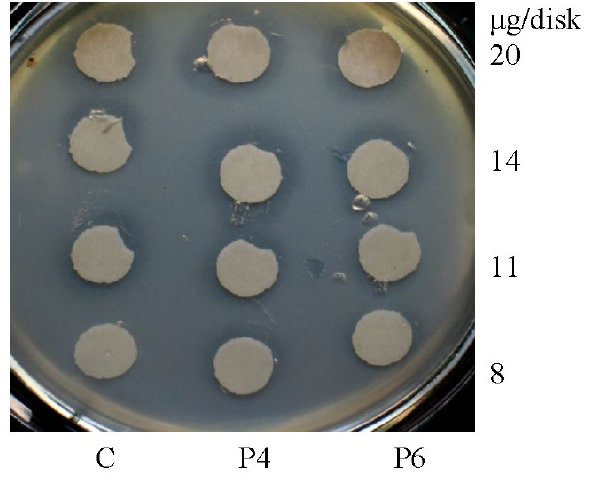
Figure 9. Growth inhibition of Escherichia coli . Table 2. Area of growth inhibition of Escherichia